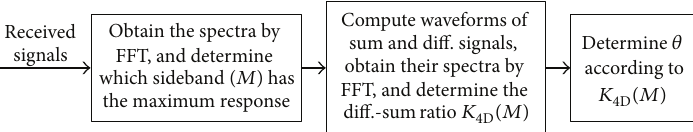
Figure 12: Calibrated difference-sum ratio 𝐾 4